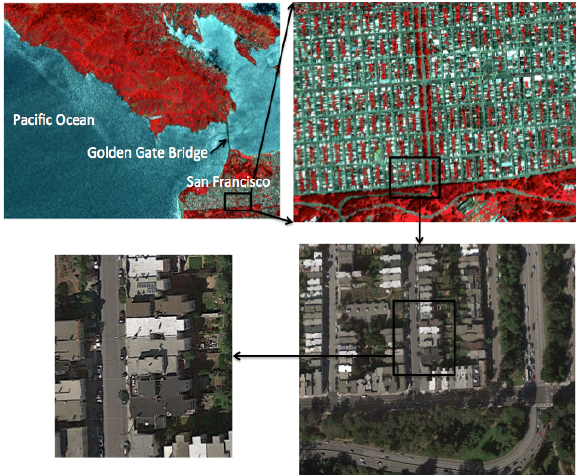
Figure 1. Study area: False colour composite (FCC) of a part of San Francisco city. Zoomed image of the urban area (marked with rectangle in inset) shows mixing of substrate with vegetation, roads, shadows and dark